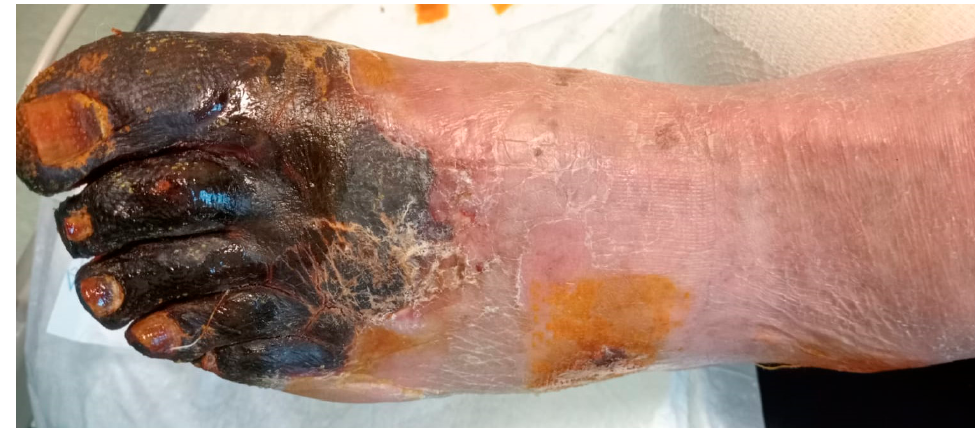
Figure 2. Extensive gangrene of the forefoot in patient with severe ischemia (WIfI grade 3).